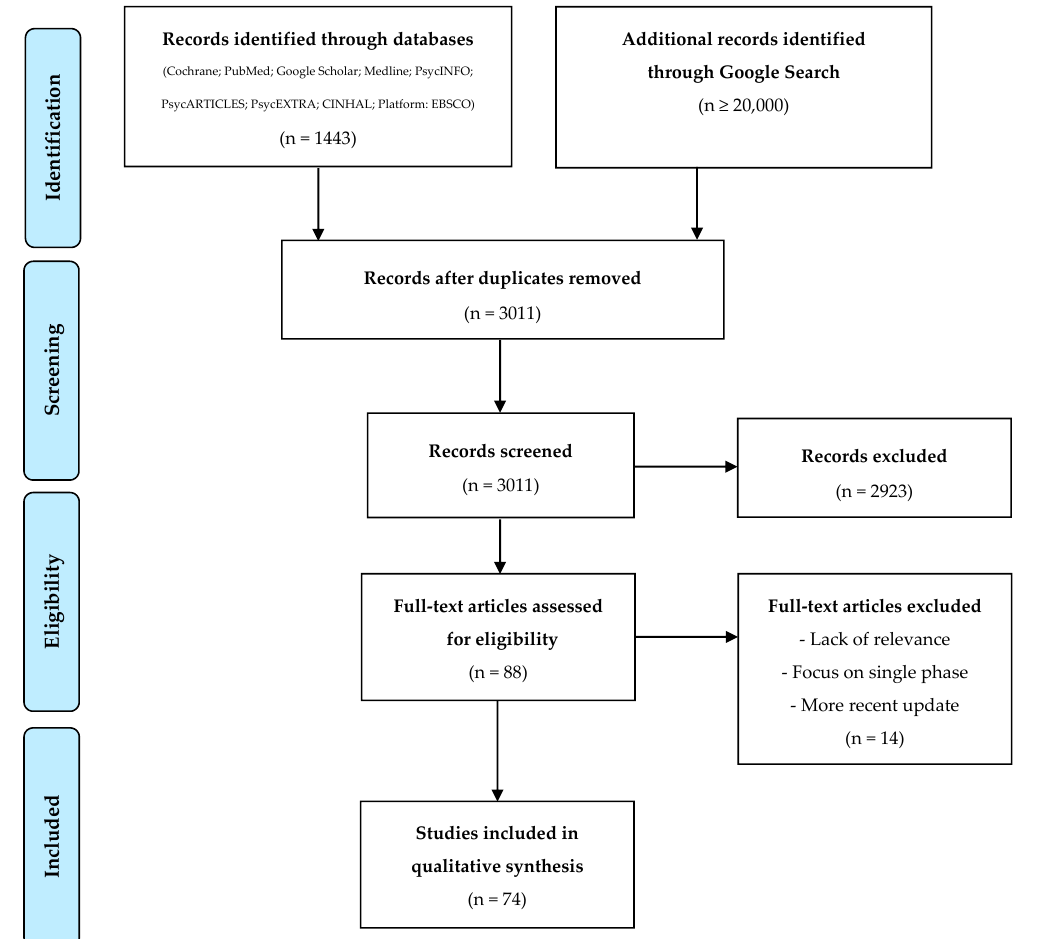
Figure 1. Flowchart for selected resources.